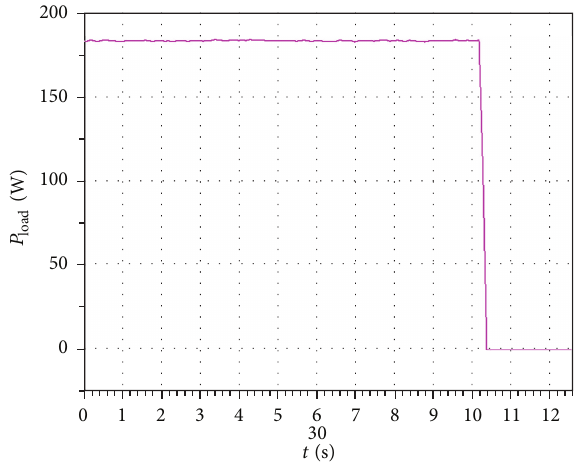
Figure 21: Active power of load for under frequency condition.